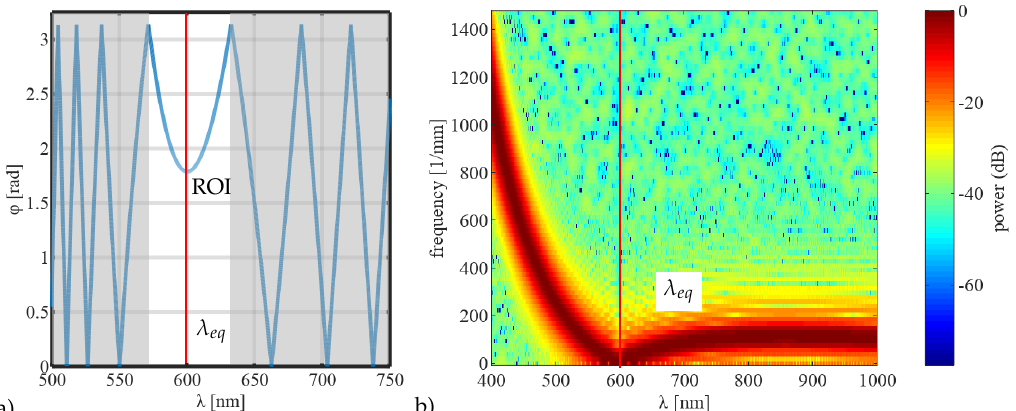
Figure 2. ( a ) Simulated phase data with ambiguities due to the cos − 1 -operation according to Equation (3) with marked equalization wavelength λ eq and region of interest ROI (marked as white band) for the extraction of a local phase and ( b ) power spectrum as a result from Short-time Fourier Transform (STFT) where the phase minimum is determined and used to define the